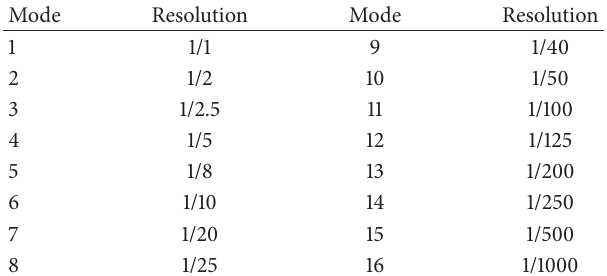
Table 1: Step division of stepper motor (full-step@1.8 ∘